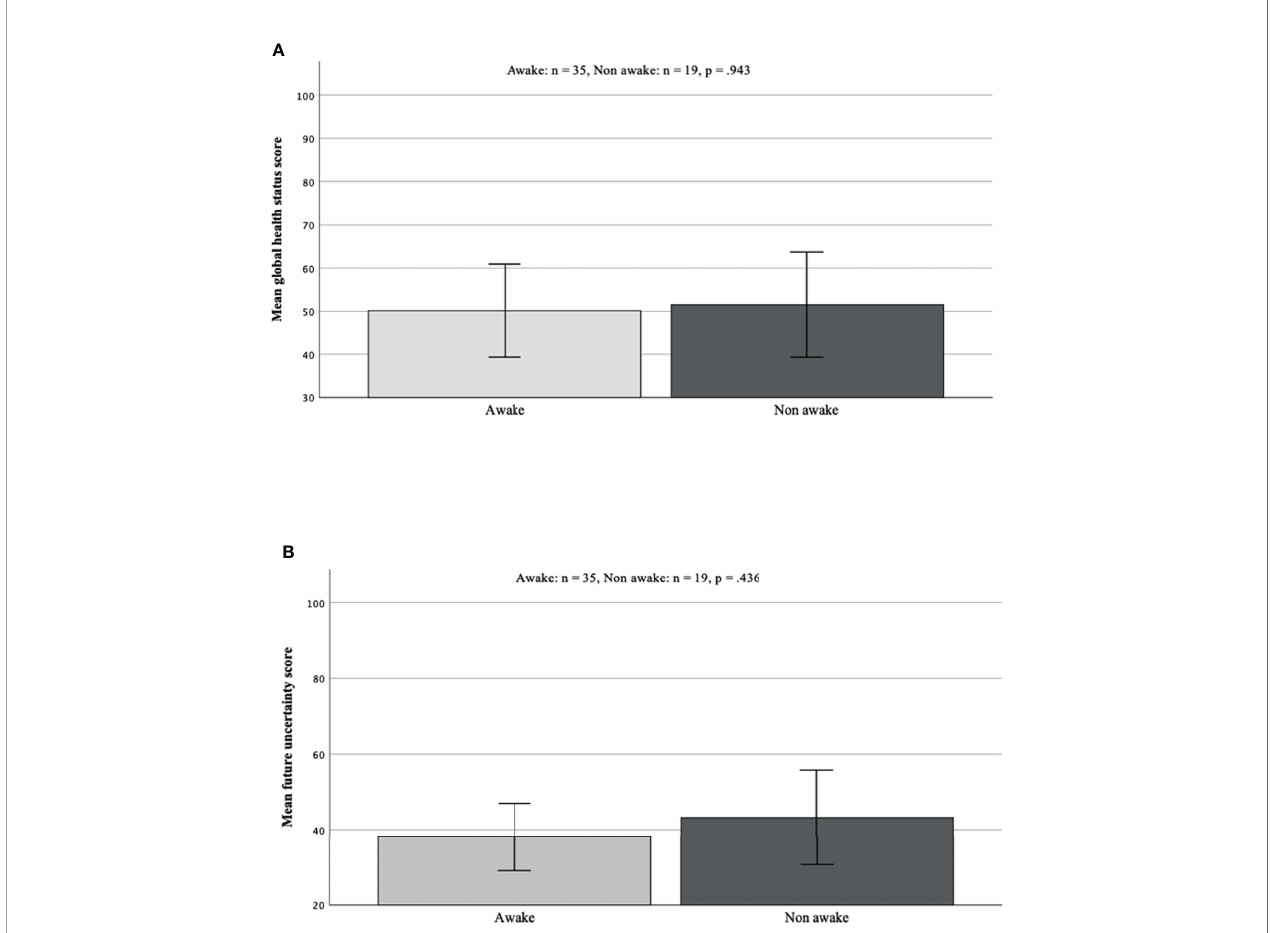
FIGURE 4 | (A, B) Analysis of differences in future uncertainty and global health status taken from EORTC QLQ-BN20 quality of life questionnaire. There was no signi fi cant difference in mean scores in both analysed items [global health status p = 0.943 (A) future uncertainty p = 0.436 (B) ]. EORTC, European Organisation for Research and Treatment of